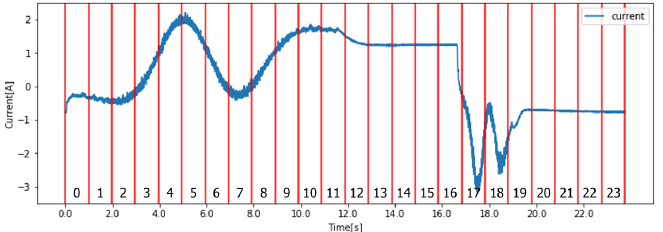
Figure 5. Sample current signal collected from the RobotBox with the segments